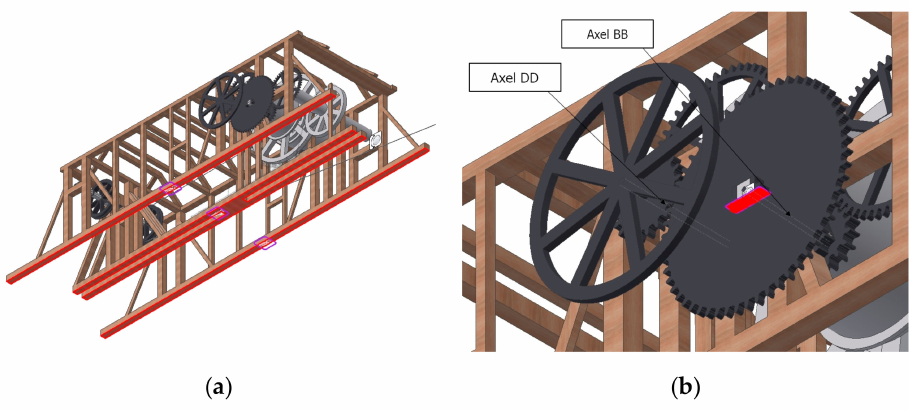
Figure 6. Fixed constraints applied: ( a ) support of the support structure ( b ) support of the BB shaft.